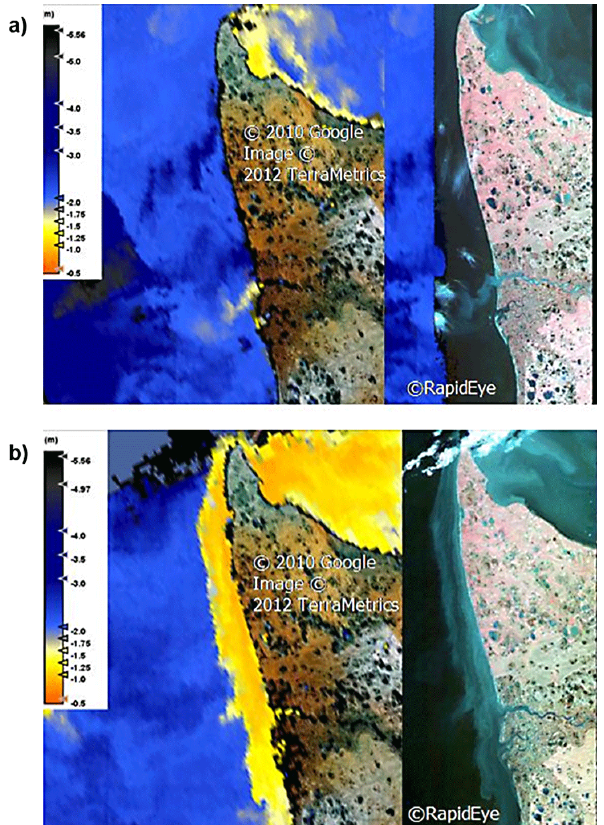
Figure 9. MERIS satellite data ( a : 8 August 2010; b : 27 August 2010) and RapidEye satellite data ( a : 8 August 2010; b : 27 August 2010) of the eastern Buor-Khaya Gulf coast. The RapidEye false- colour NIR composite has a spatial resolution of 6.5m. The colour- coded MERIS map shows C2R_Z90 (m − 1 ) . At the beginning of August the coastal waters along the eastern Buor-Khaya Gulf coast show a high transparency, and a spatially confined turbid river in- flow into the Buor-Khaya Gulf is visible. After storm events at the end of August 2010 a turbidity zone along the eastern Buor-Khaya Gulf coast above the shallow submarine slope is